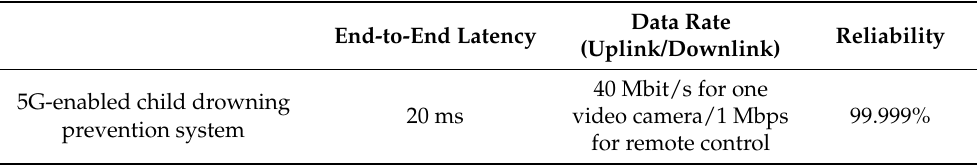
Table 1. Main KPIs for child drowning